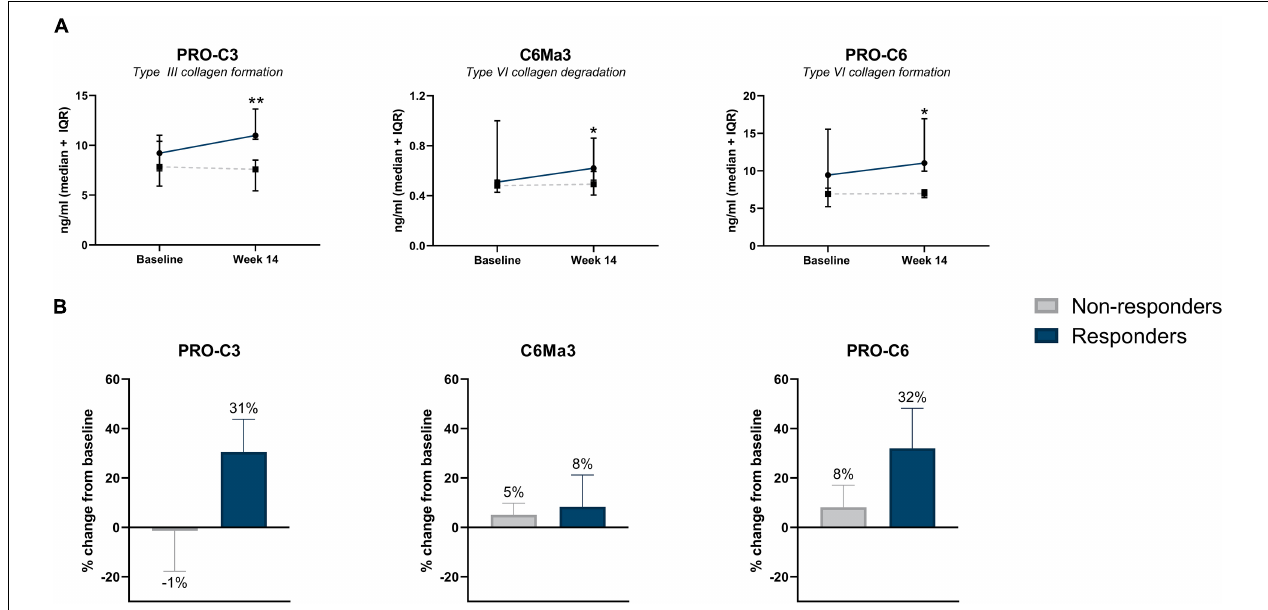
FIGURE 2 | (A) Serum biomarker levels in CD patients with surgical history, stratified by response to IFX treatment. Serum levels of collagen type III formation (PRO-C3), type VI degradation (C6Ma3), and type VI formation (PRO-C6) were elevated at week 14 in patients responding to treatment compared with non-responders ( P = 0.004, P = 0.032, P = 0. 037). Data are shown as median + IQR. (B) Percent change from baseline of type III collagen formation, type VI collagen degradation and formation between responders and non-responders within CD patients with history of prior surgery. * P < 0.05; ** P <